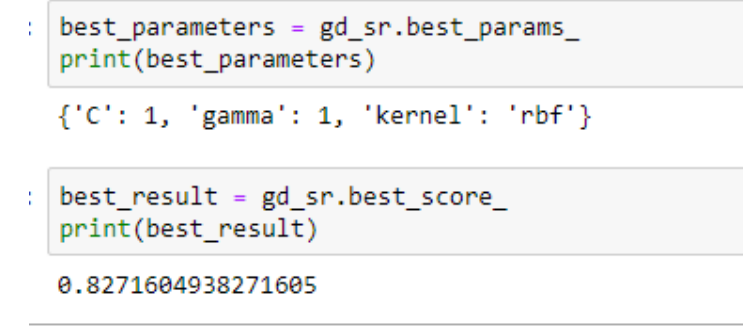
Figure 26. The best parameters with obtained after performing a grid search with 5-Fold Cross-Validation on the SVM-RBF model. Table 8. Accuracies achieved by performing 5-Fold Cross-Validation on the SVM-RBF model.